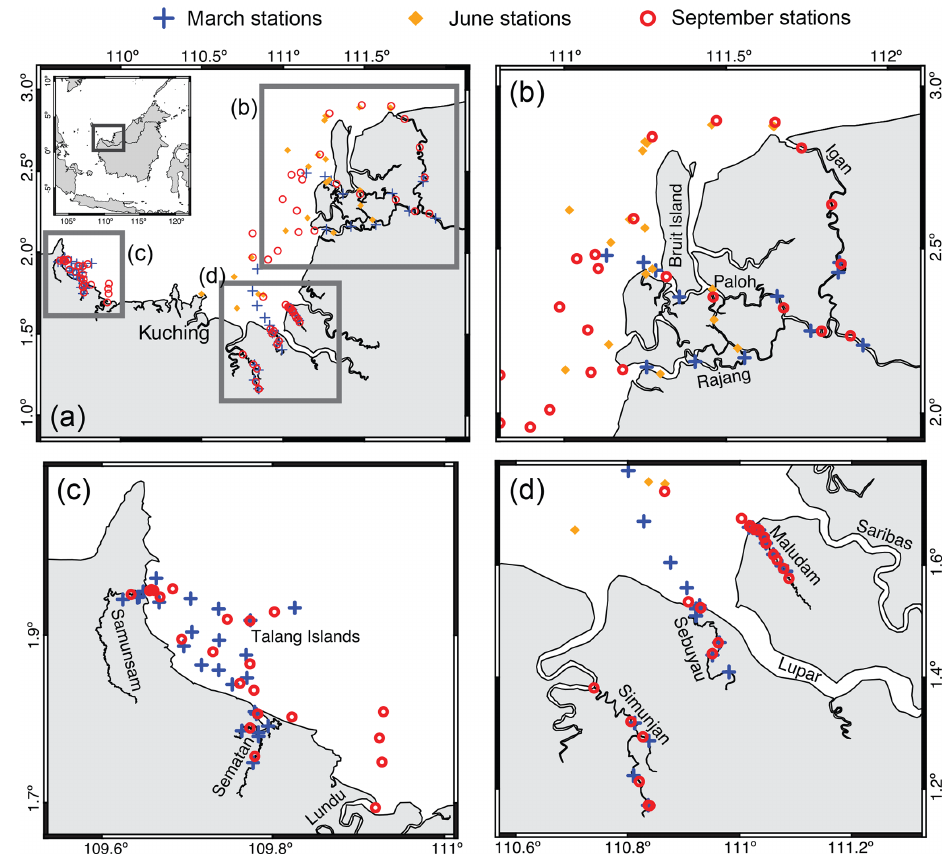
Figure 1. (a) Map of the study region and sampling sites (Martin et al., 2018). (b–d) A zoomed in view of the three